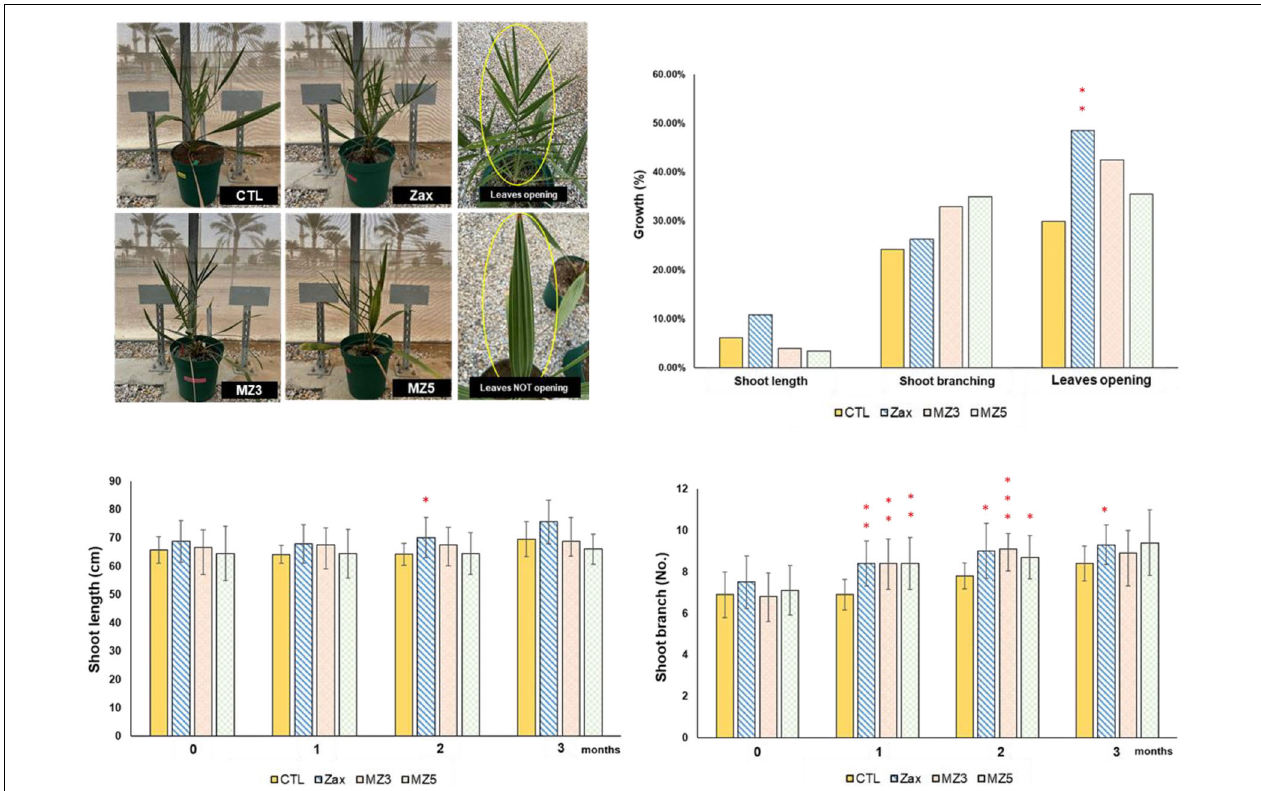
FIGURE 2 | Effect of foliar application of Zax, MZ3, and MZ5 at 5 µ M on date palm plants under open field condition, performed in 2021. Data represent mean ± SD. n = 10. Statistical analysis was performed using the two-tailed Student’s t -test. Asterisks indicate statistically significant differences as compared to CTL ( ∗ p < 0.05, ∗∗ p < 0.01, ∗∗∗ p < 0.001). CTL, control; Zax, zaxinone; MZ3, MiZax3; MZ5, MiZax5.